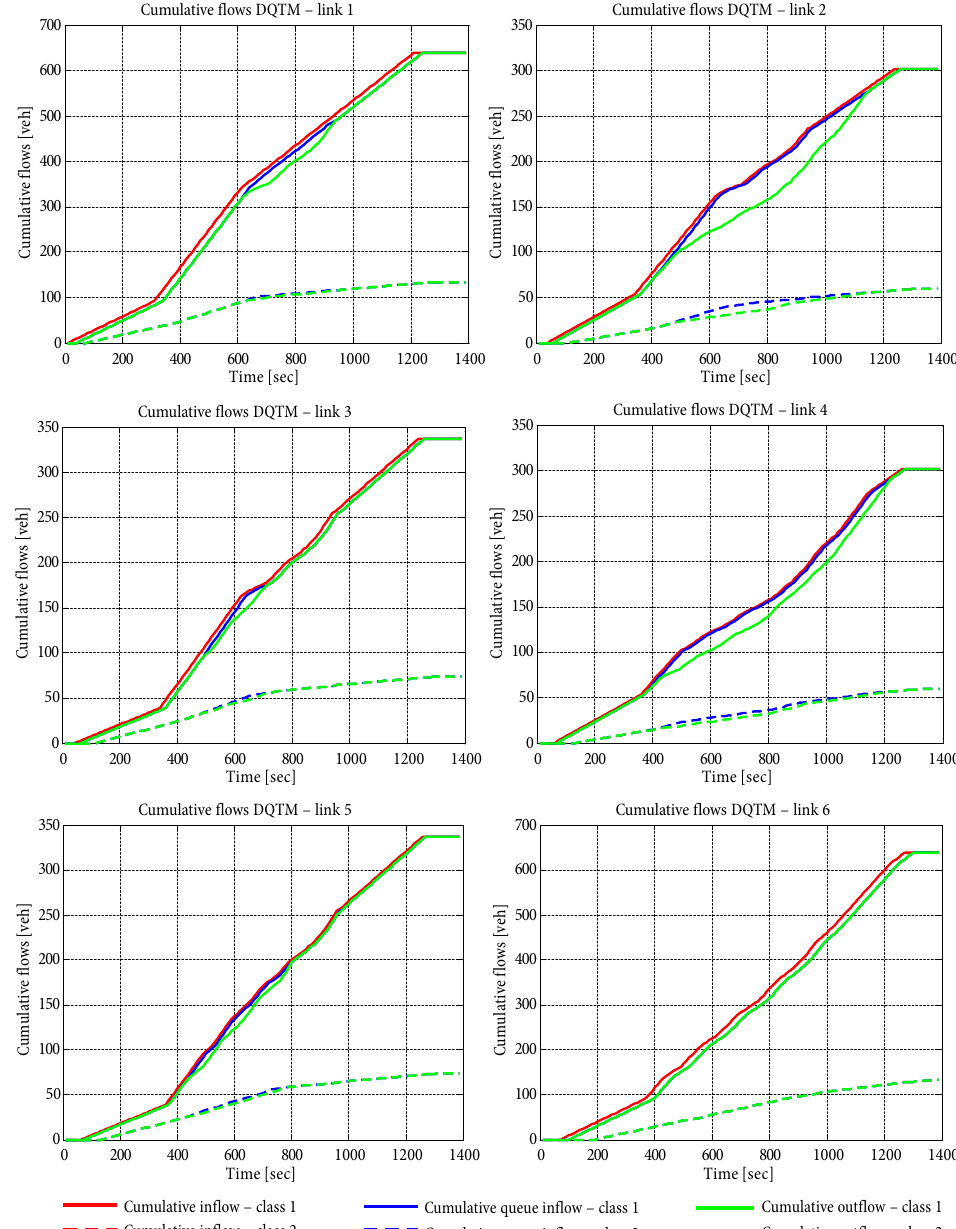
Fig. 8. Cumulative flows for multi-class